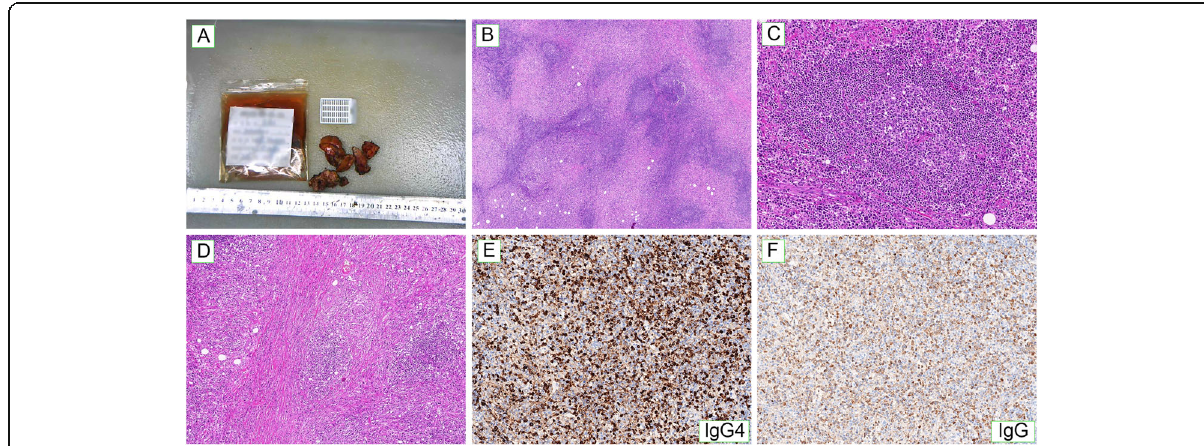
Fig. 4 Histopathologic features of the masses in case 2. (A) Gross observation of resected masses. (B) Increased degree of fibrosis and dense infiltration of plasma cells and lymphocytes in the specimen (40×). (C) Plenty of lymphocytes and plasma cells infiltrate and form germinal centers (200×). (D) Storiform-type fibrosis and obliterative phlebitis (100×). (E,F) Immunohistochemistry revealed many IgG (E) and IgG4 (F) positive plasma cells